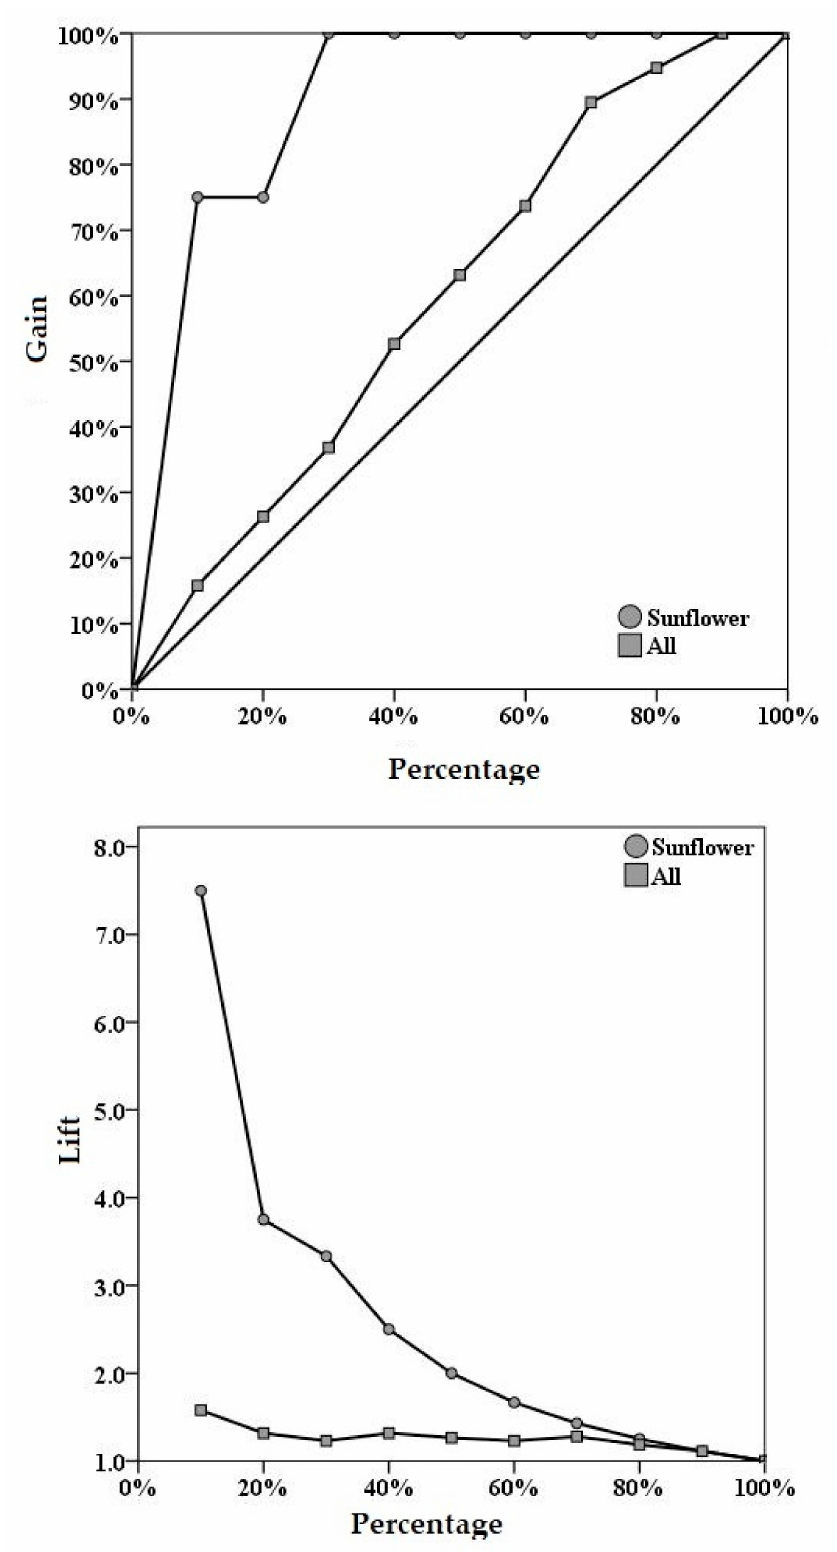
Figure 6. Gain and lift charts obtained from MLP-ANN modeling of oil samples. The lift chart is “obtained” from the gain chart, the values from the gain chart being used for calculation of lift factors. For example, the second point of sunflower line from gain chart